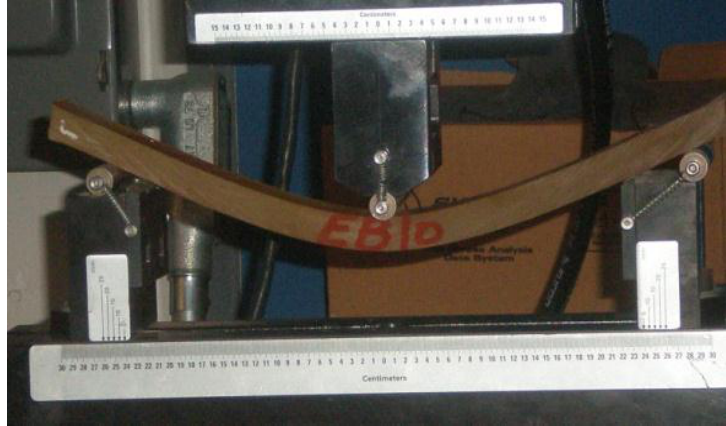
Figure 4. Large deflection of the epoxy beam (EB10) after 40 Cycles at 100 °C.